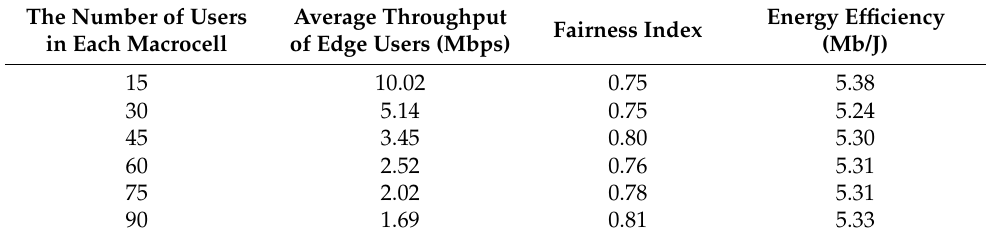
Table 3. Simulation results under different network user scales. The Number of Users Average Throughput in Each Macrocell of Edge Users (Mbps)